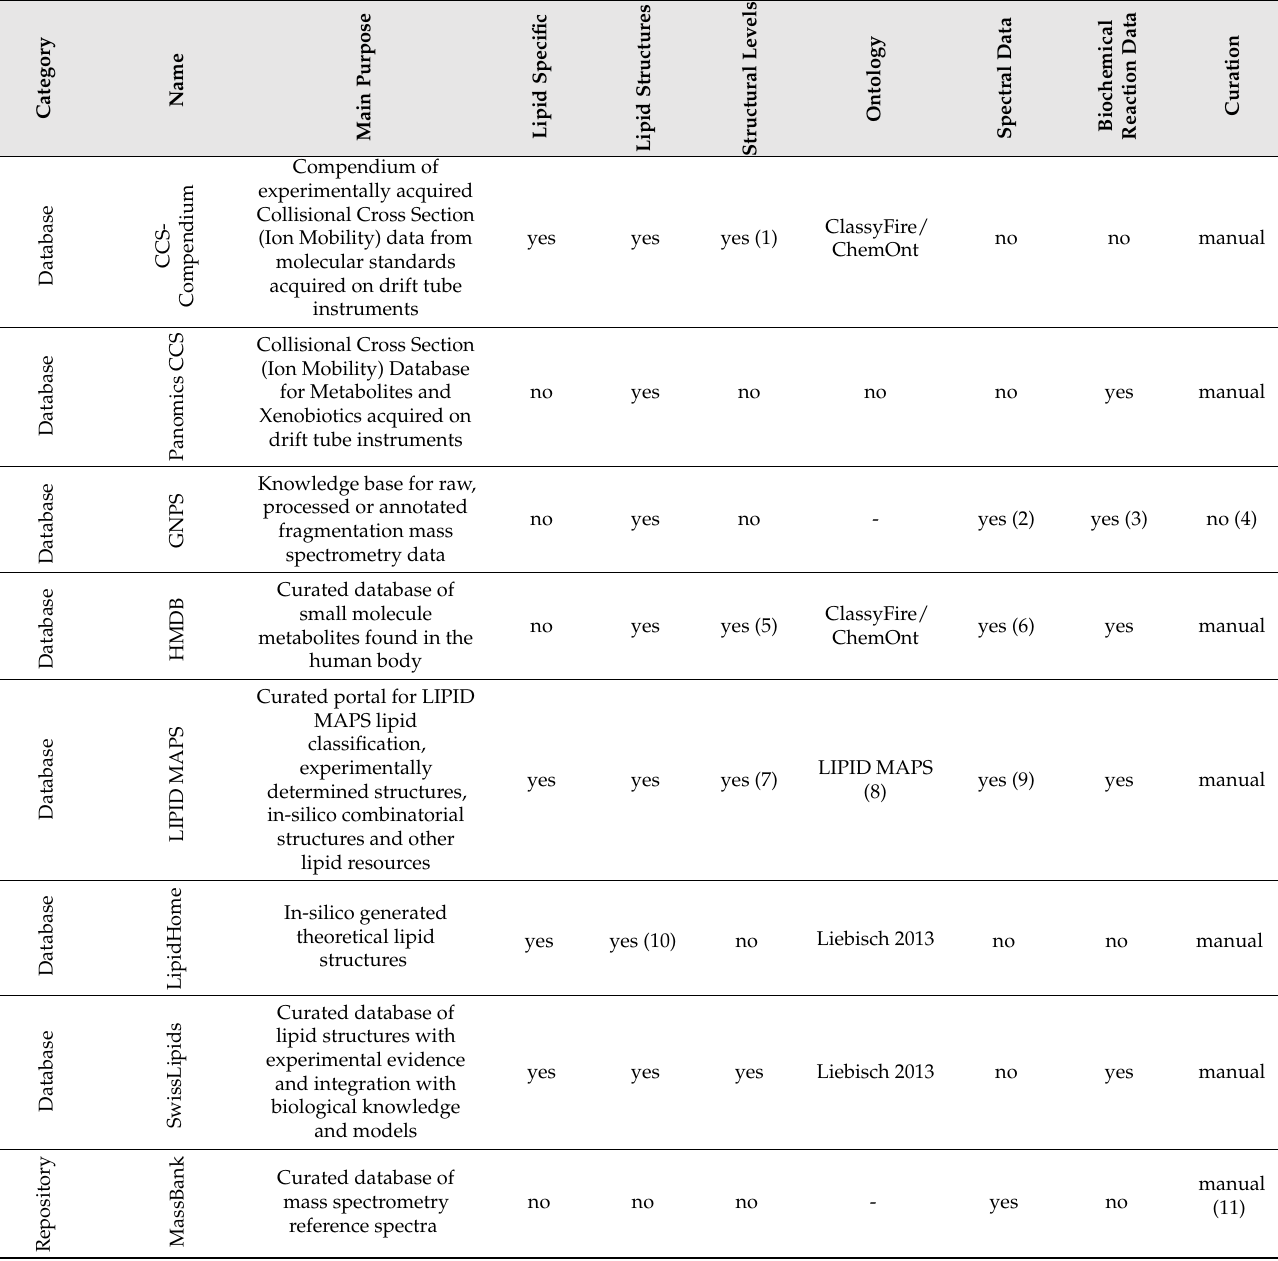
ISA-Table. (14) based on submission format mwTab. (15) others are available, e.g., LIPID MAPS, SwissLipids. (16) metabolic pathways of lipid mediators. (17) not necessarily machine readable.